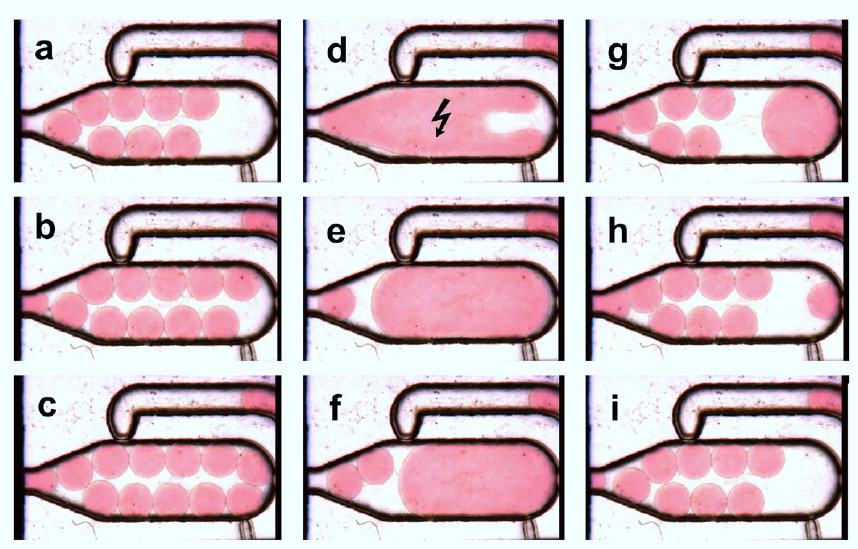
Figure 7. Image series of multiple-droplet coalescence mode (Figure 2D): Always 12 droplets (red dyed) of about 40 nL are delivered into the chamber ( a – c ). The main chamber nozzle acts as a barrier for the droplets. When the chamber is filled a defined electrocoalescence pulse merge all droplets ( d ). The blocked bypass initiates the droplet release from the chamber, which is forced by the feeding carrier media ( e ). As the coalesced droplet passes through the main chamber nozzle, new small droplets refill the chamber ( e – i).